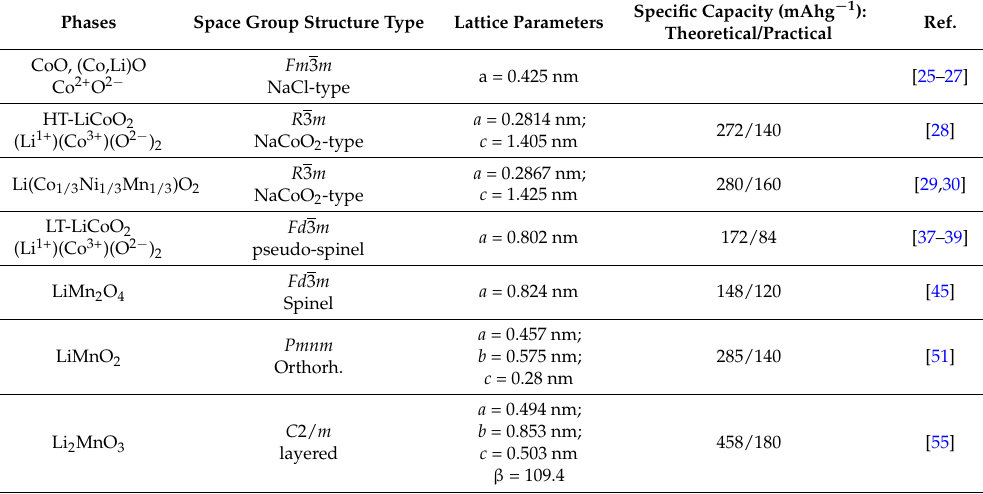
Table 1. Oxide structures of cathodes for the Li-ion batteries considered in this paper. Abbreviations: high-temperature (HT); low-temperature